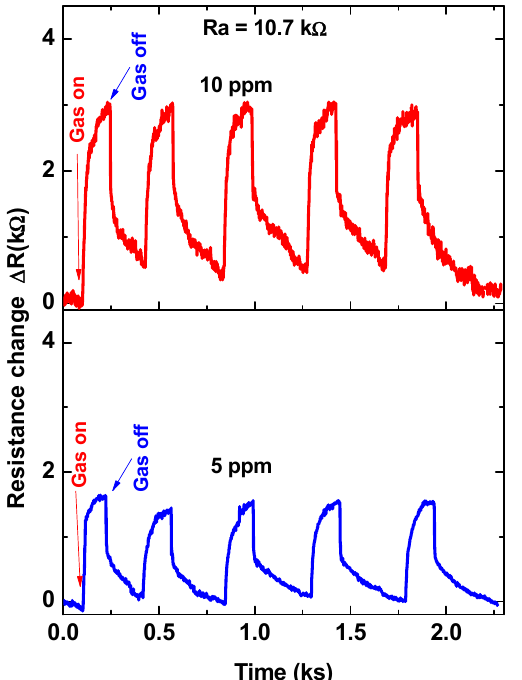
◦ C for 5 ppm and 10